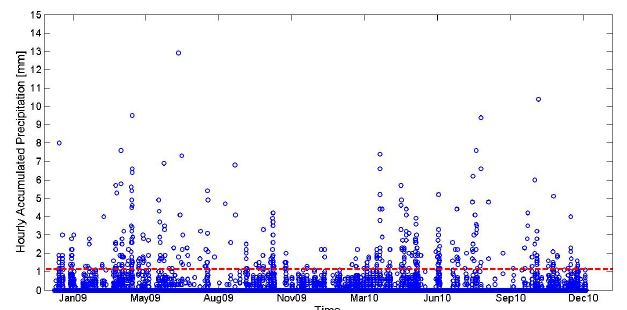
Fig. 8. Time series of hourly accumulated precipitation observations in 2009–2010. The dotted redline is the range parameter threshold beyond which data should be flagged ( ∼ 2.3% of the data should be